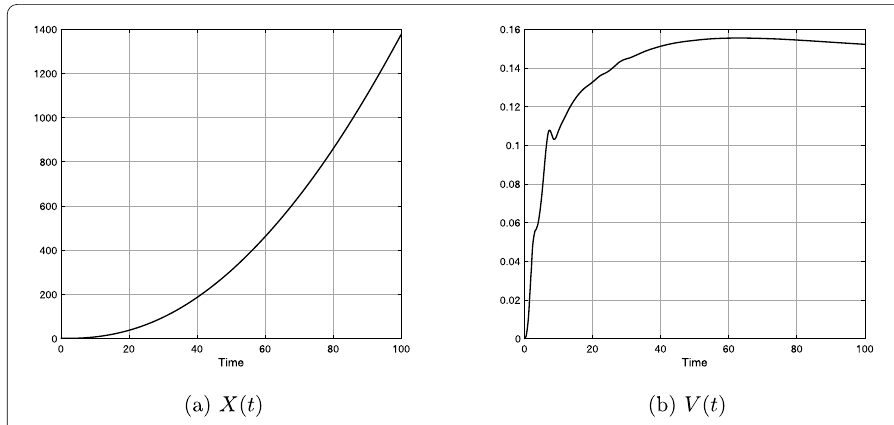
Figure 8 Dispersion and disagreement of Case II for t ∈ [0,100]